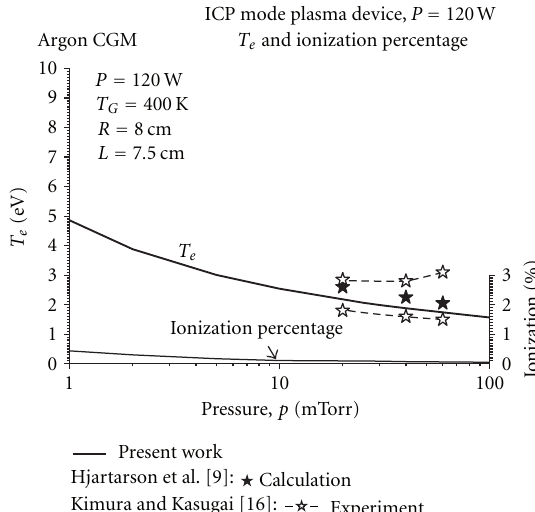
Figure 12: Calculated T e and ionization percentage for 1mTorr < p < 100 mTorr compared with values of Hjartarson et al. [9] and of Kimura and Kasugai [16].